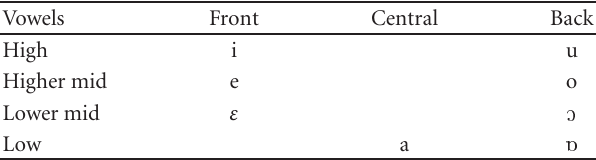
Table 1: Assamese vowel phoneme table obtained from